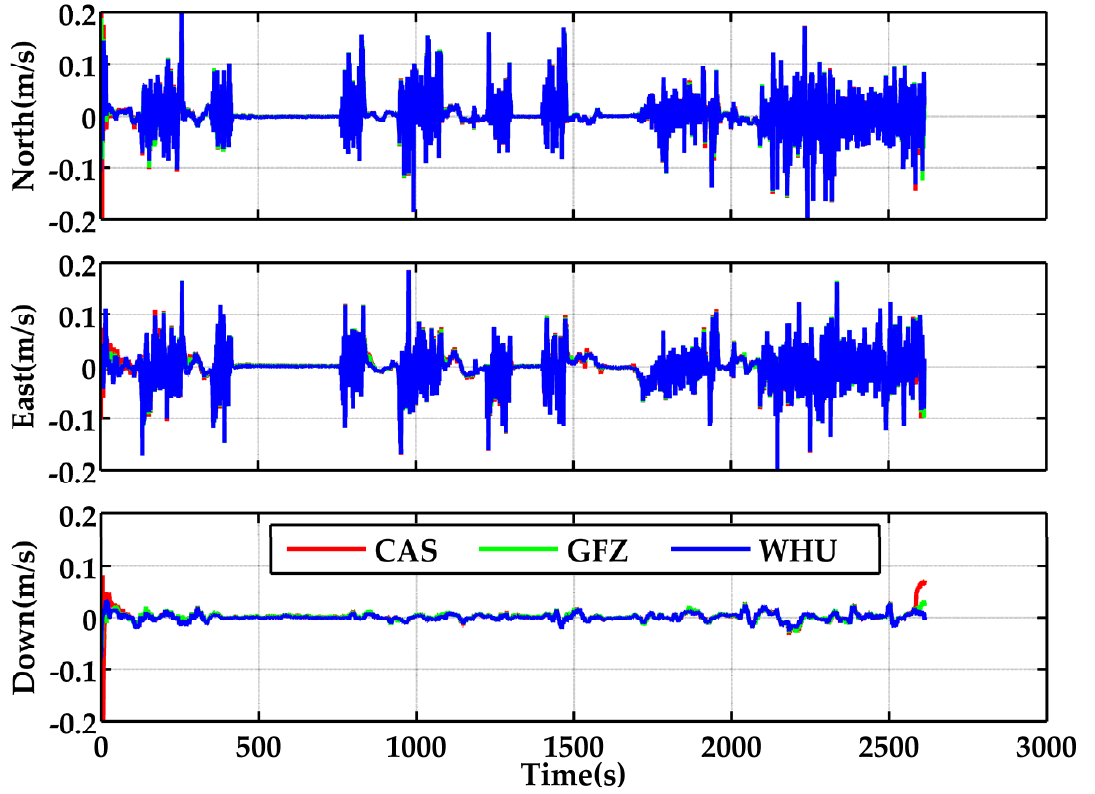
Figure 12. Velocity offsets of G + B SF-PPP/INS tight integration in the three directions using the real-time products from CAS, GFZ, and WHU, in terms of reference solutions (the start time is 195,453 s).